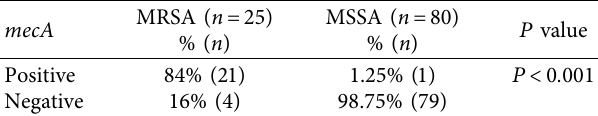
Figure 1: Partial PCR amplifcation bands 16s rRNA and mecA . Table 1: Te mecA carried in MRSA and